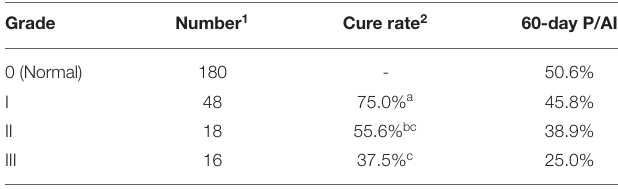
TABLE 5 | Ultrasonography-based diagnosis of ovaries at the first implementation of the OvSynch program and 60-day P/AI after the first AI in M + C program. Ovarian cycle